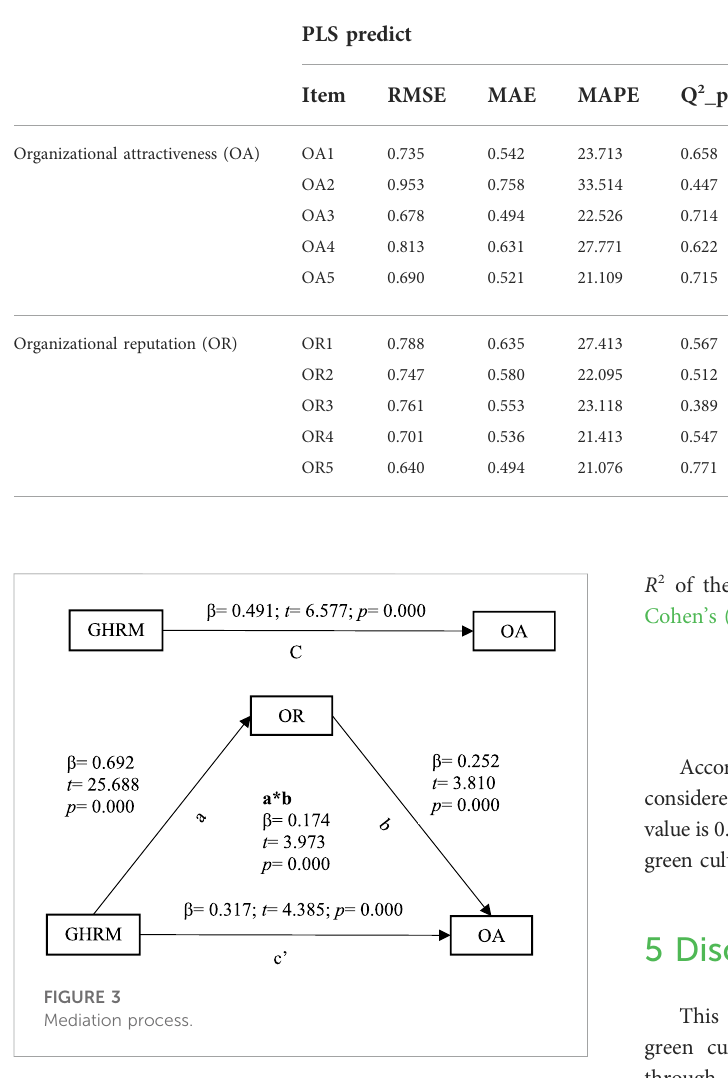
TABLE 5 PLS predict.